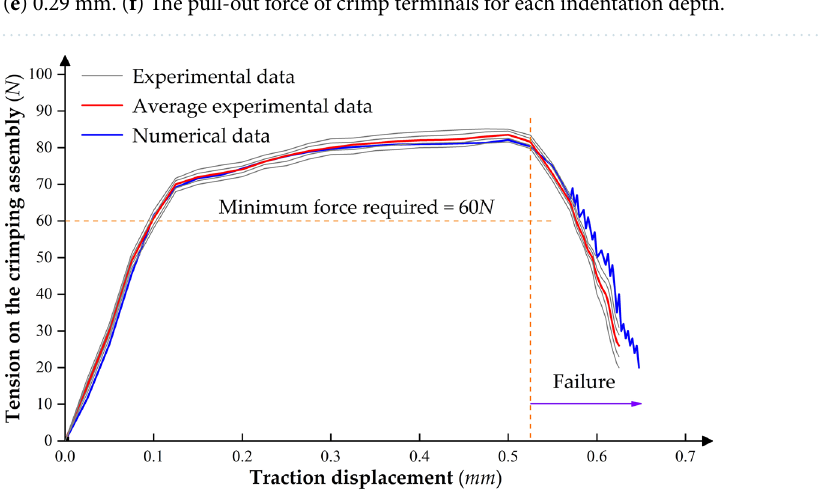
Figure 12. Experimental and simulated force–displacement curves for the tensile strength of the crimping assembly corresponding to the 3# crimping